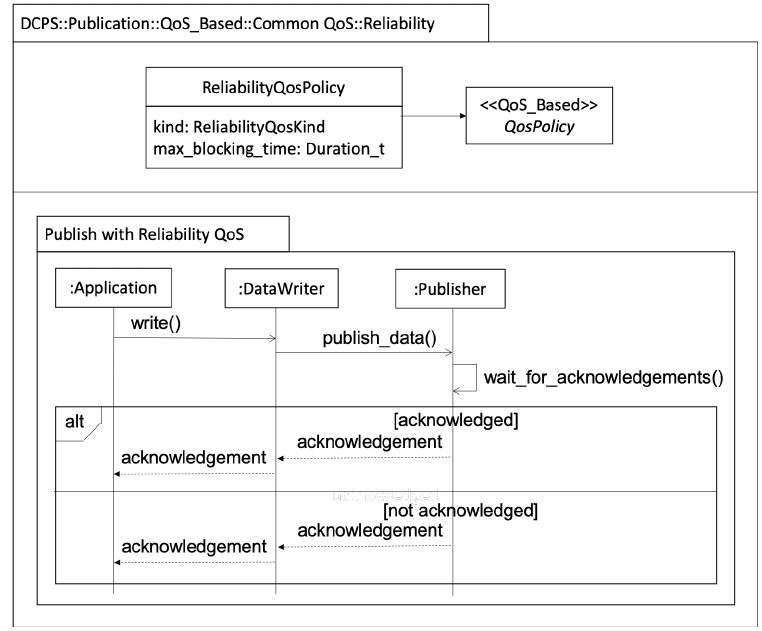
Figure 9. Reliability